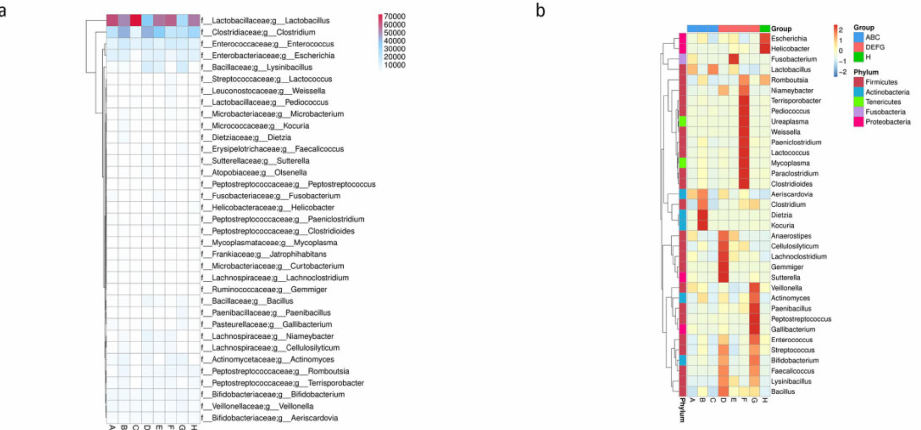
Figure 8. Cluster heatmap of the number and abundance of genes at the genus level. ( a ) Unannotated number statistical heatmap; the horizontal axis is the sample name; the vertical axis is the species information; and different colours represent the number of unigenes. ( b ) Cluster heatmap of relative abundance at the genus level; the horizontal direction is the sample information; the vertical direction is the species information. The cluster tree on the left in the figure is a species cluster tree. The value corresponding to the intermediate heatmap is the Z-value obtained after the relative abundance of species in each row is normalised; that is, the Z-value of a sample in a certain classification is the value obtained by dividing the difference between the relative abundance of the sample in that classification and the average relative abundance of all samples in that classification by the standard deviation of all samples in that